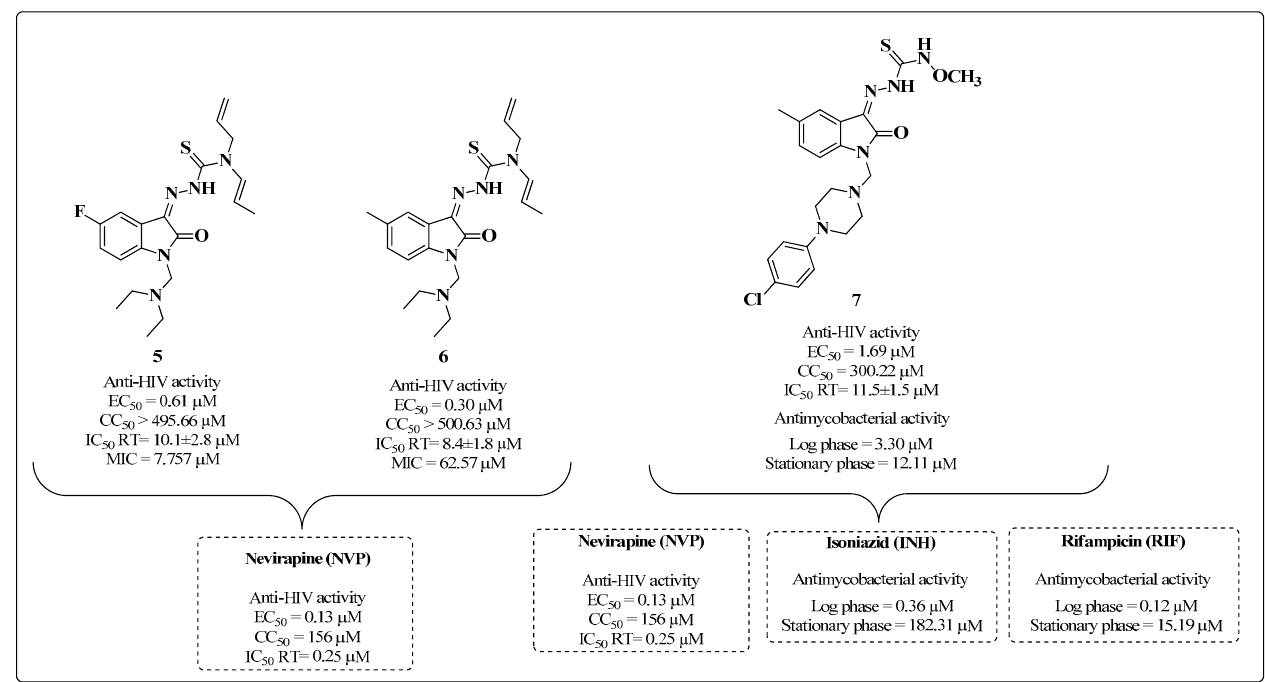
Figure 10. Anti-HIV and anti-MTB activities of isatin-thiosemicarbazone derivatives 5 – 7 [82–88]. Evaluation of Compounds 5 and 6 on the HIV-1 RT enzyme resulted in mean inhibi- tory concentration (IC 50 ) values of 10.1 ± 2.8 µM and 8.4 ± 1.8 µM, respectively (Figure 10).